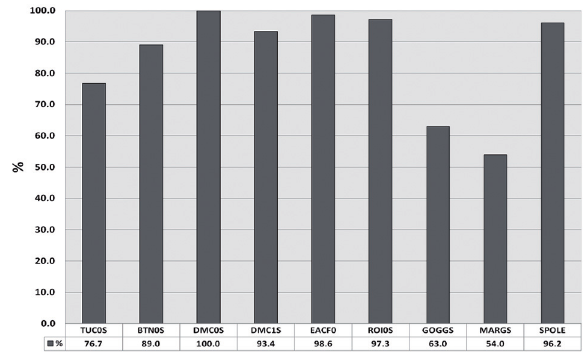
Figure 2. Percentage of days of available data in 2011 for each re-